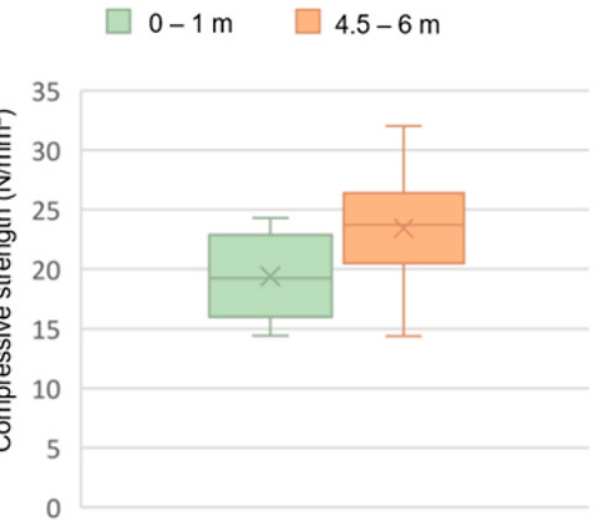
Figure 16. Compressive strength of Paulownia samples extracted at 0 − 1 m and 4.5 − 6 m from the tree stem.